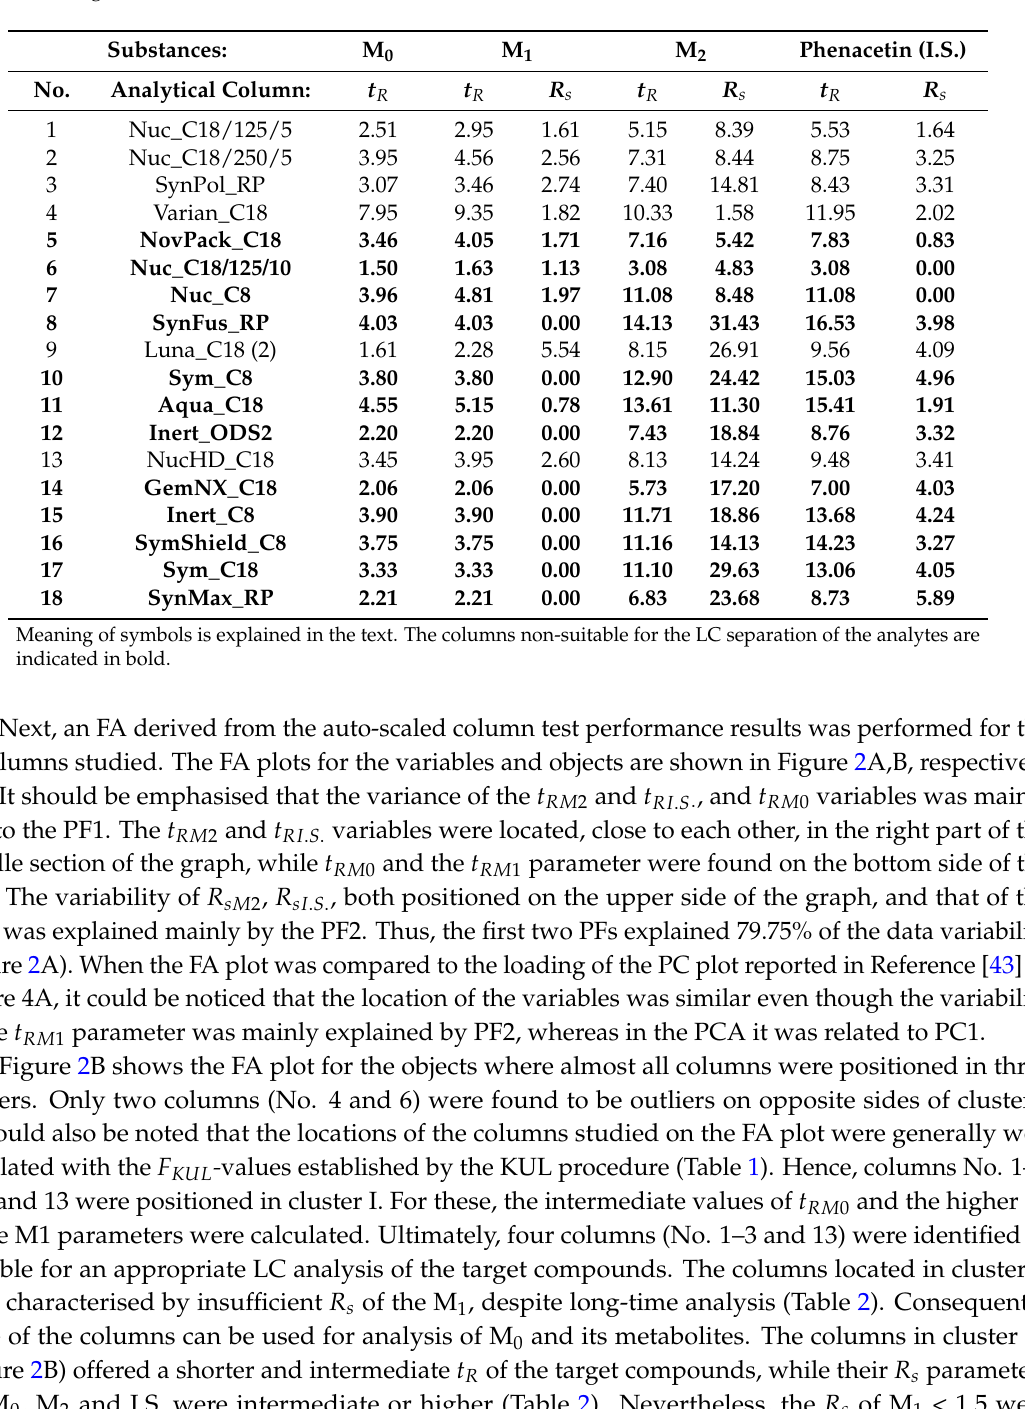
Table 2. Summary of data set of t R and R s for M 0 , its two metabolites and I.S. in column performance test for eighteen columns